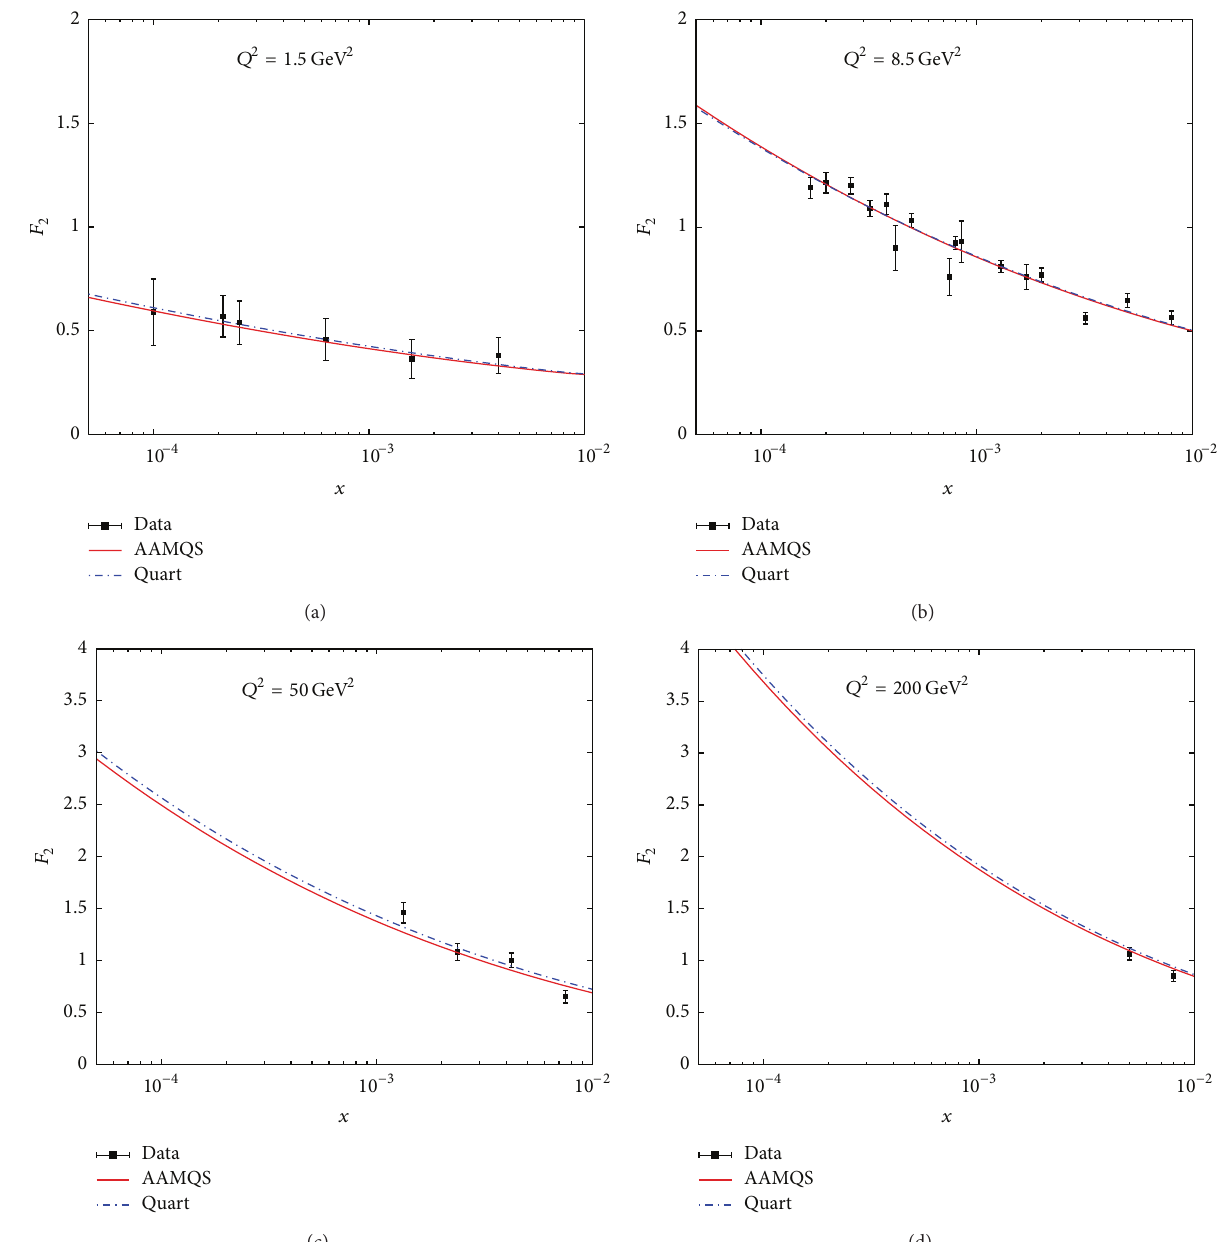
Figure3:Protonstructurefunction 𝐹 2 (𝑥,𝑄 2 ) versus 𝑥 atdifferent 𝑄 2 .ThesquaresrepresenttheexperimentaldataoftheHERACollaboration [53–55]. The solid and dashed-dotted curves represent the results calculated by the AAMQS and quartic action initial conditions,